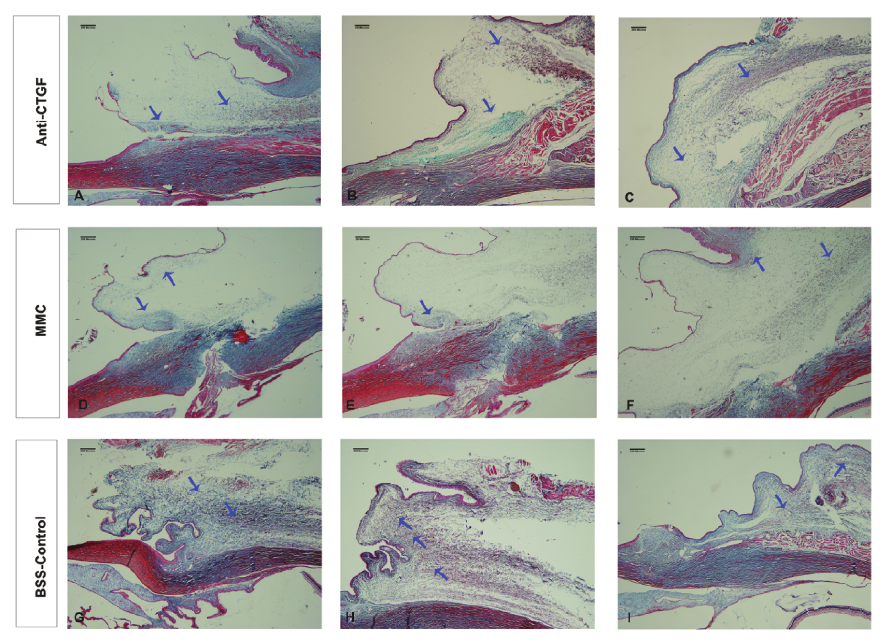
Figure 2. Representative photomicrographs of trabeculectomy blebs in the study groups. Note the lower content of blue-stained collagenous tissue in the trabeculectomy blebs of the anti-CTGF (A, B, C), MMC (D, E, F), and control (G, H, I) eyes. Blue arrows point to the more prominent, blue-stained collagenous tissue in the bleb areas. Other diffused, blue-stained areas were also entered in the Image J analysis (Masson’s trichrome staining).